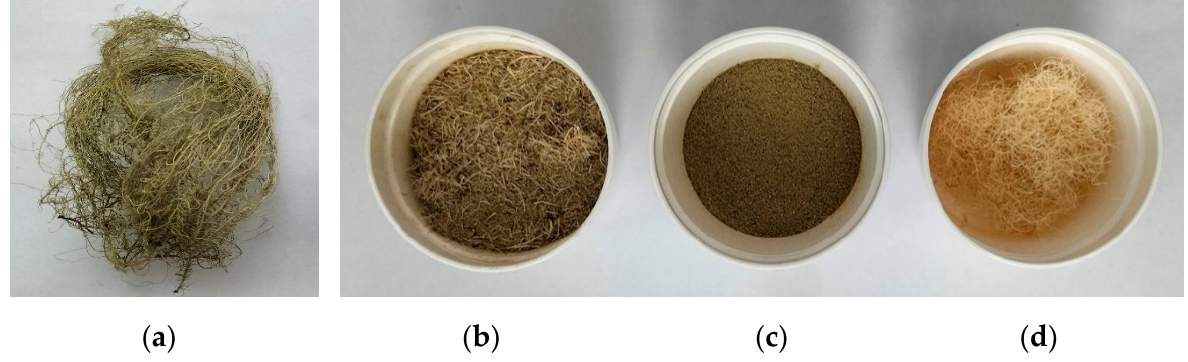
Figure 1. U. barbata dried lichen—entire thallus ( a ) and ground— d UB ( b ) ; both separated fractions: medulla–cortex— mc UB ( c ) and central cord— cc UB ( d ).